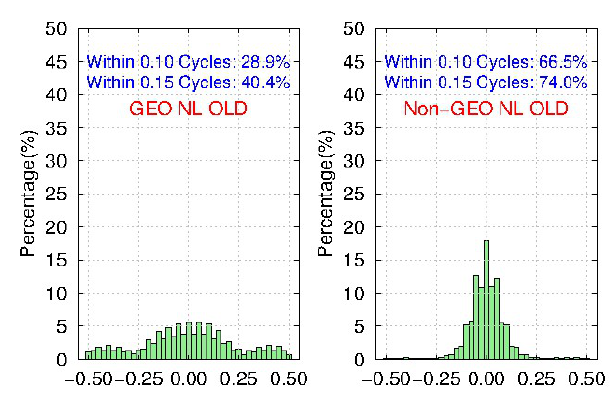
Figure 15. The distribution of BDS NL fractional parts after removal of FCBs estimated by the traditional strategy for 103 MGEX stations during DOY 061-090, 2018.